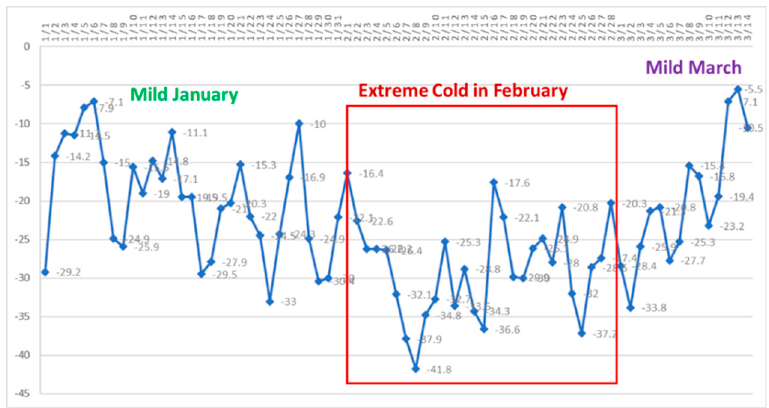
Figure 2. Daily minimum temperature (°C) for 1 January 2019 to 11 March 2019 for Regina, Saskatchewan (Source: Environment and Climate Change Canada).